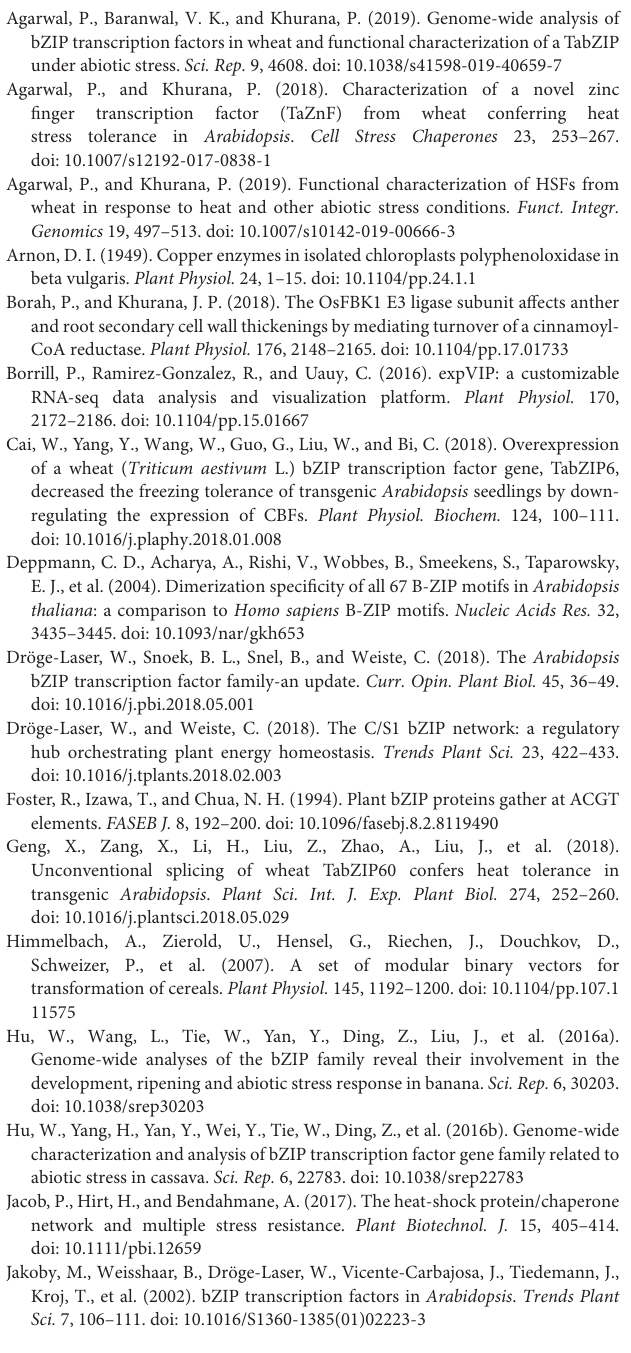
Supplementary Figure 6 | Confirmation of TaOBF1-5B Arabidopsis overexpression transgenic lines by (A) Hygromycin resistance gene specific PCR (B) Gene-specific PCR (C) RT-PCR. Supplementary Figure 7 | Generation of rice transgenics by tissue culture. Transformation of rice calli with Agrobacterium harboring TaOBF1-5B gene.